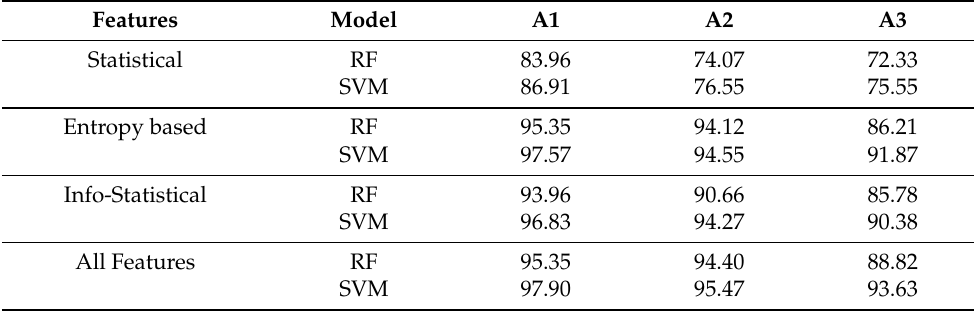
Table 5. Percentage accuracy for fault classification using the vibration signals of the RC dataset.